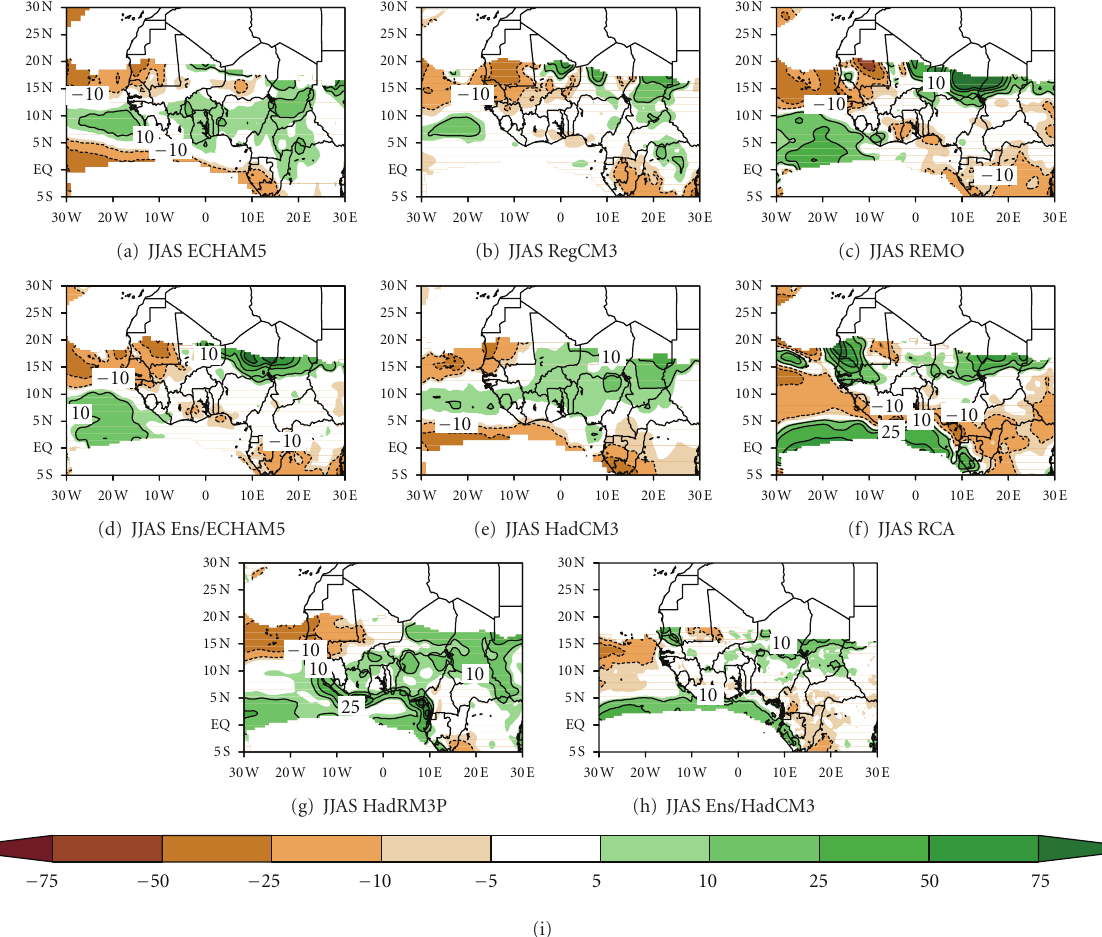
Figure 9: Averaged JJAS di ff erence between the future (A1B: 2031–2050) and the reference period (1981–2000) of temperature from: (a) ECHAM5, (b) RegCM3, (c) REMO, (d) Ens/ECHAM5 (mean ensemble of RCMs driven by ECHAM5), (e) HadCM3, (f) RCA, (g) HadRM3P, and (h) Ens/HadCM3 (mean ensemble of RCMs driven by HadCM3).